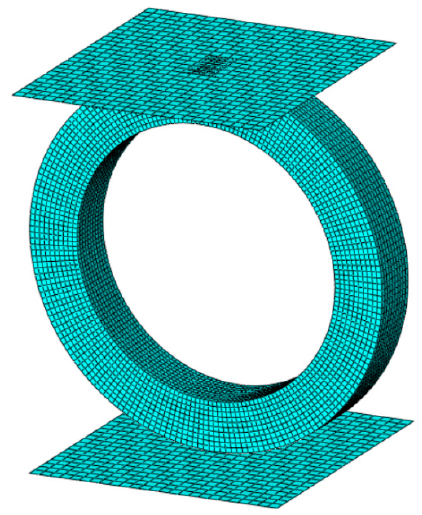
Figure 7. A discrete model of the analyzed ring.